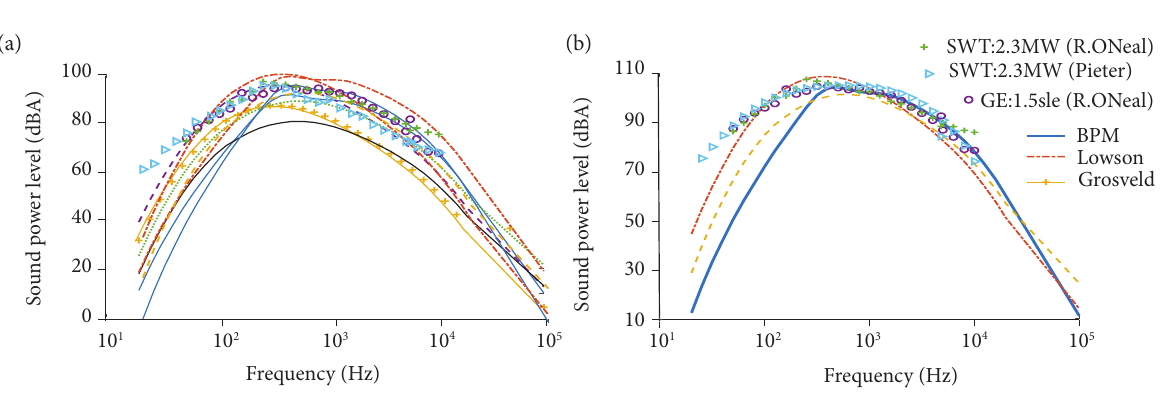
Figure 3. Validation of BPM, Grosveld and Lowson baseline models with OASPL experiment results of Dijkstra (2015) and O’Neal et al. (2009) for 2.3 MW turbine and GE 1.5sle turbine (O’Neal et al. 2009) (a) at wind speed of 8 m/s, receiver height of ~2 m located at 120 m from turbine; (b) at wind speed of 10 m/s, receiver height of ~2 m located at 120 m from turbine.